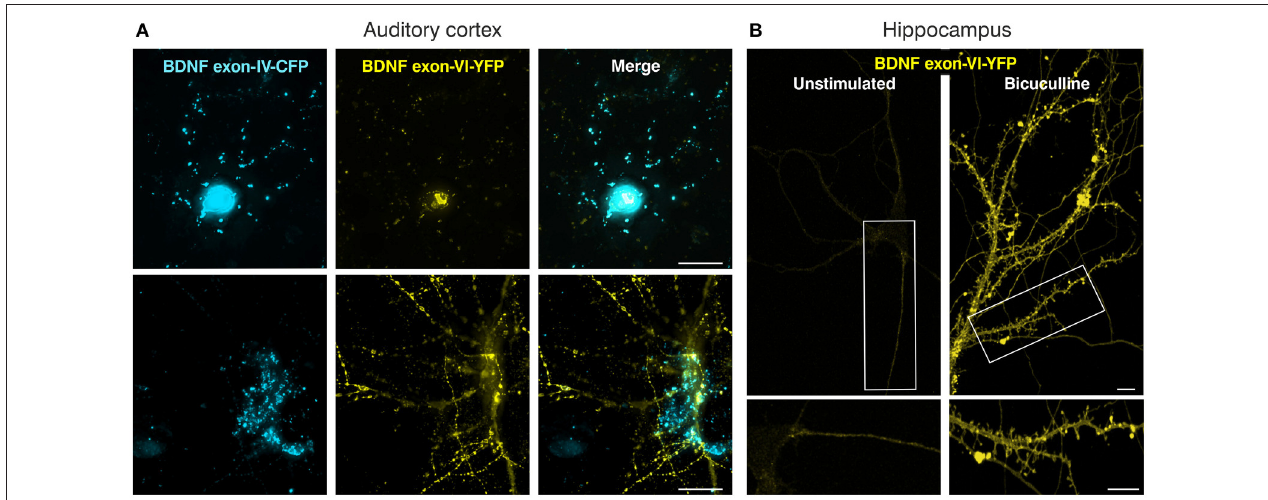
FIGURE 2 | Verification of the BLEV double construct in primary neuronal cultures. (A) Mouse primary cortical cell culture (postnatal day 2) transfected with the BDNF double construct. Left panels: Bdnf exon-IV-CFP expression; middle panels: Bdnf exon-VI-YFP expression; right panels: merged images. Top and bottom panels represent two different neurons. Scale bar: 20 µ m. (B) Transfected rat primary hippocampal neurons (embryonic day E18) without (left) or with bicuculline (right) stimulation showing Bdnf exon-VI-YFP expression. Bdnf exon-IV-CFP expression showed an increase preferentially in the cell body ( Supplementary Figure 2A , arrows), while exon-VI-YFP was predominantly detected in proximal and distal regions of the neurites ( Supplementary Figure 2B , lower panels). Scale bars: 10 µ m.